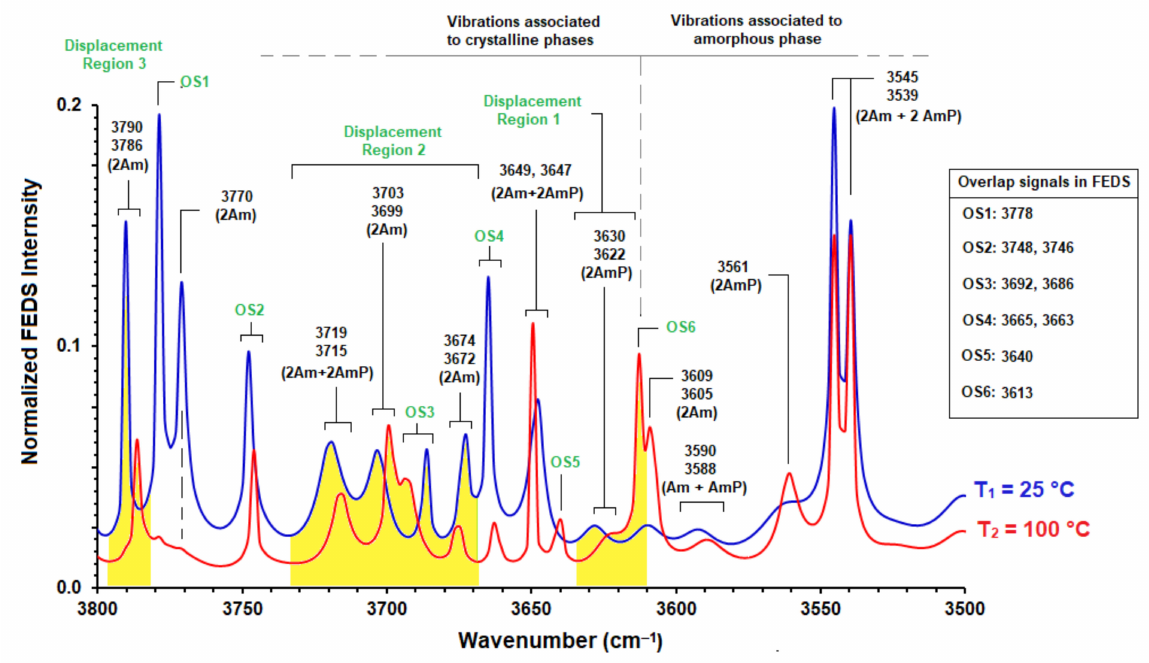
Figure 4. Comparison of spectra T 1 and T 2 between 3800 and 3500 cm − 1 . Changes into spectra are related to the spectrum zone recognized to show vibrations from the crystalline